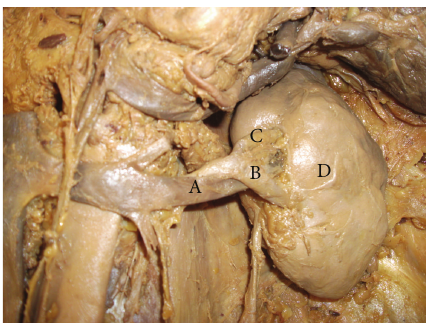
Figure 1: Left renal hilum (anterior view). (A) Left renal vein, (B) leftanteriorinferiorsegmentalrenalartery,(C)leftanteriorsuperior segmental renal artery, and (D) left